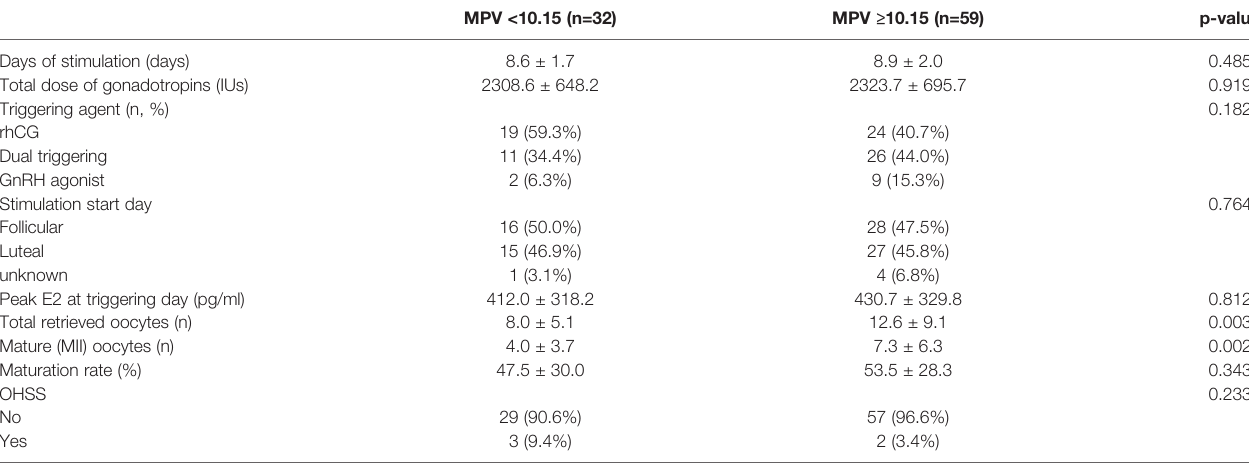
TABLE 3 | Controlled ovarian stimulation outcomes of patients with breast cancer at the MPV cutoff value 10.15